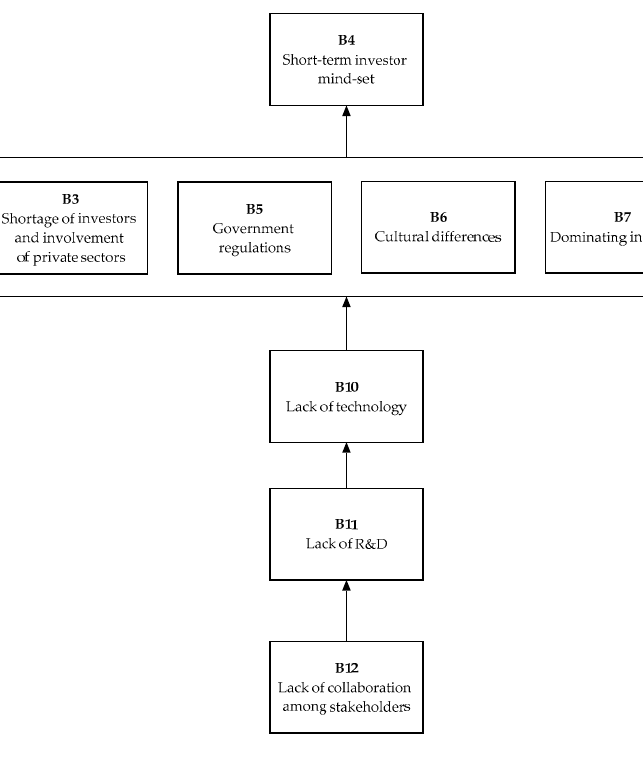
Figure 2. The final ISM digraph of barriers to green entrepreneurship (GE).